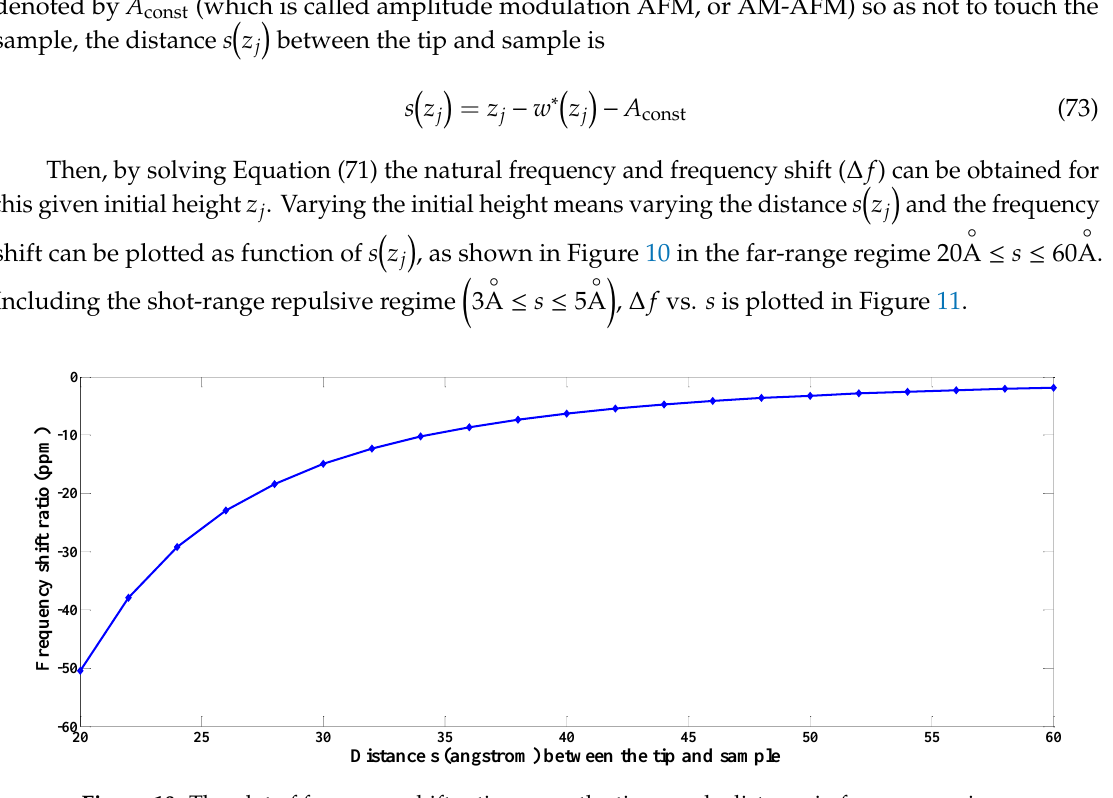
Figure 10. The plot of frequency shift ratio versus the tip-sample distance in far-range regime.